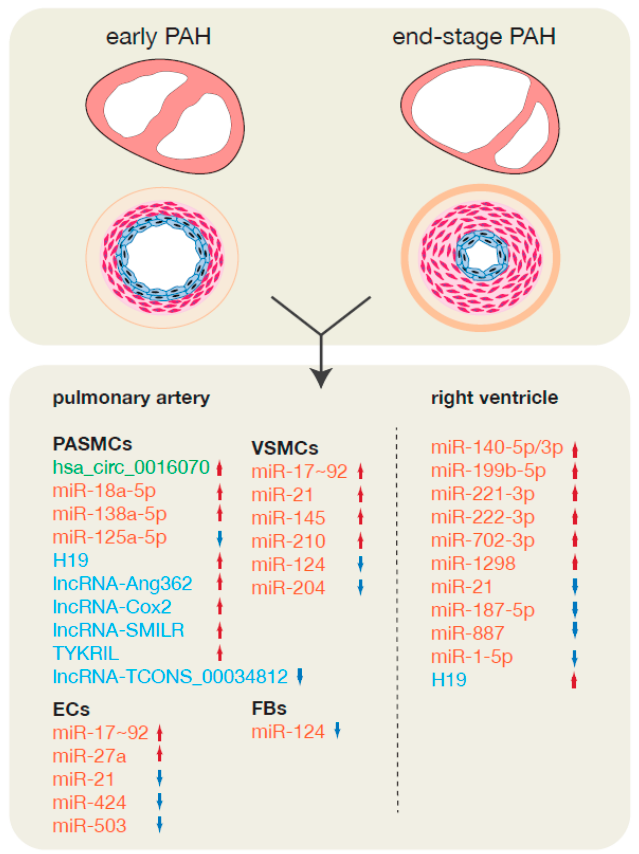
Figure 4. ncRNAs involved in PAH-induced pulmonary artery and RV remodeling. During disease progression, multiple ncRNAs are dysregulated in the different vascular and cardiac cell types, and compared to healthy tissues. miRNAs are depicted in red, lncRNAs in blue and circRNAs in green. Red and blue arrows represent gene up- or downregulation, respectively, in either the pulmonary artery or the